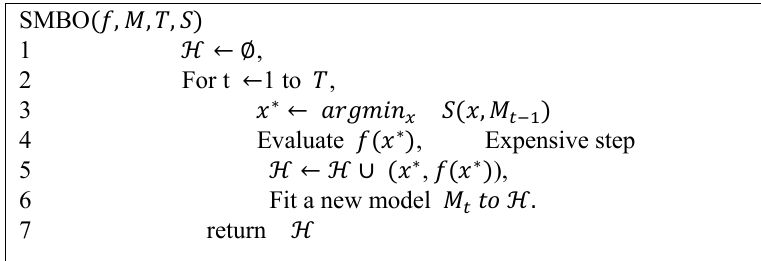
Figure 9. The pseudo ‐ code of sequential model ‐ based optimization, where 𝑓 is the objective function, 𝑀 is a cheaper ‐ to ‐ evaluate surrogate model, S is an auxiliary criterion function.